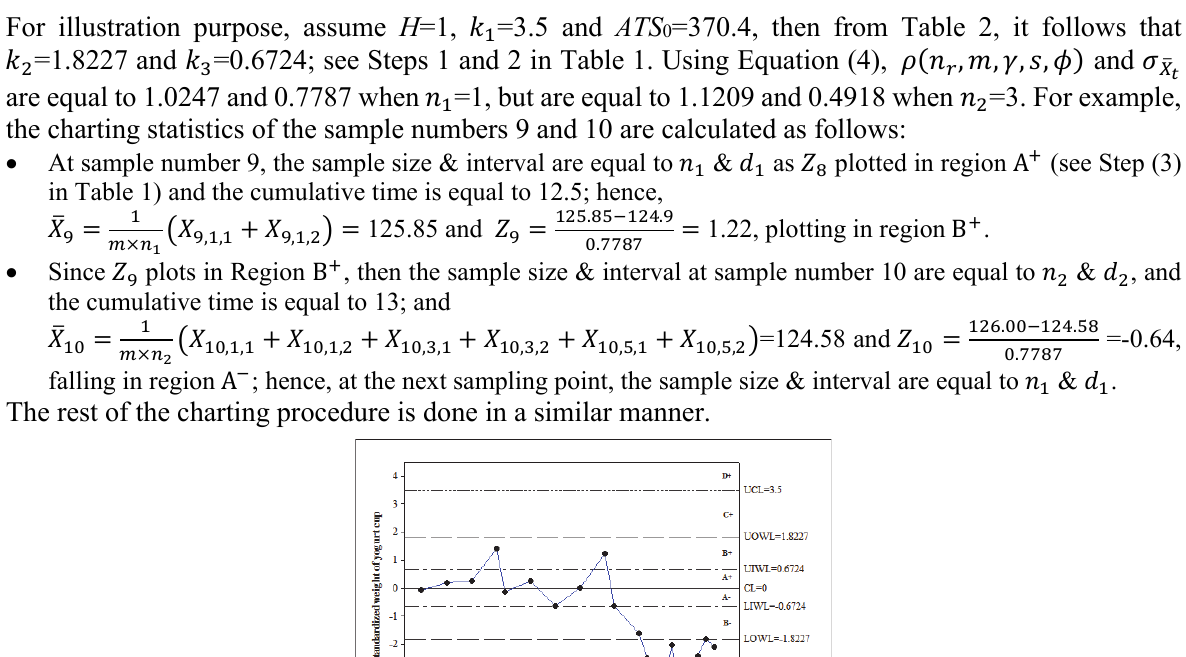
= 0.24 𝑔 , so that 𝛾 = 0.316. (cid:3014)